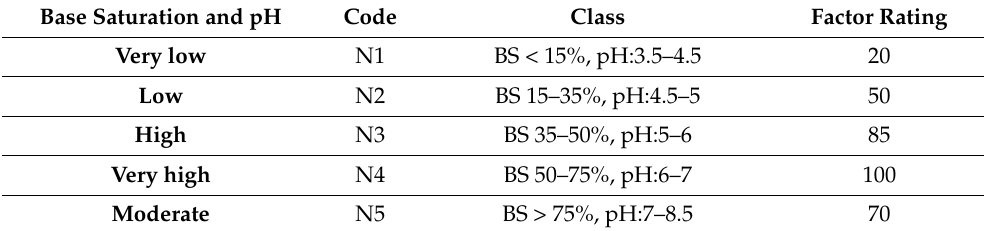
Table 7. Factor ratings of base saturation and pH.